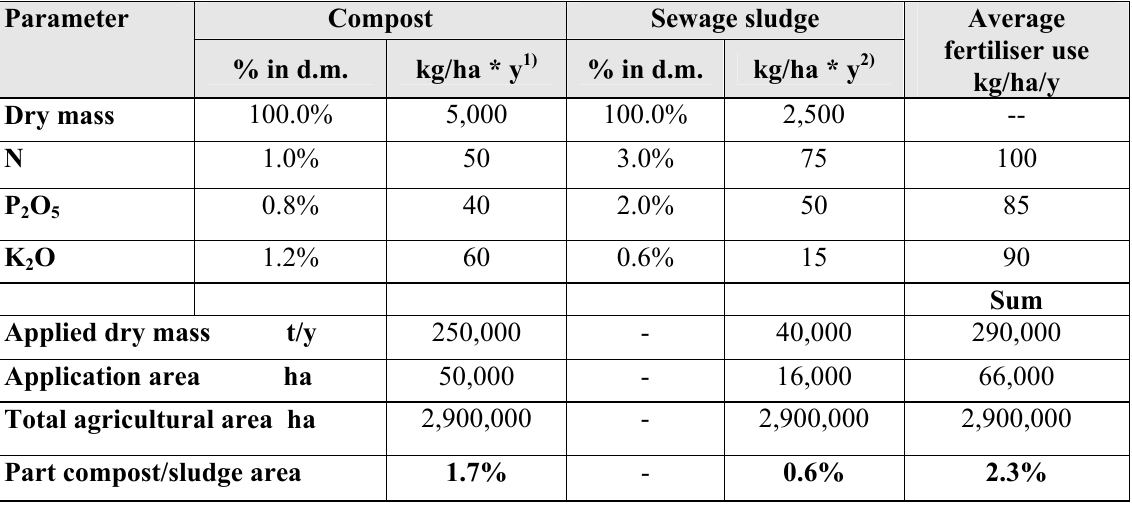
Table 48: Substituting effects of compost/sludge and application area (Wiegel, 2005) Compost Sewage sludge